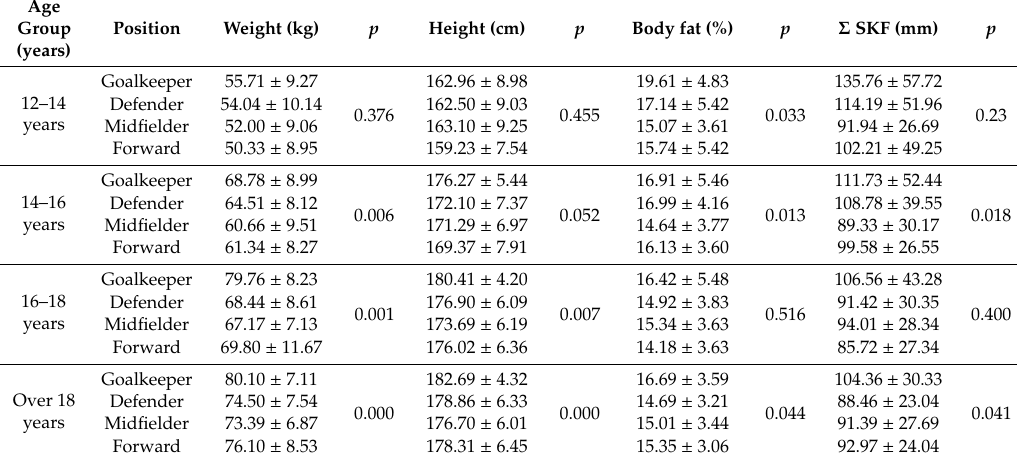
Table 2. Descriptive values by chronological age group and playing position.